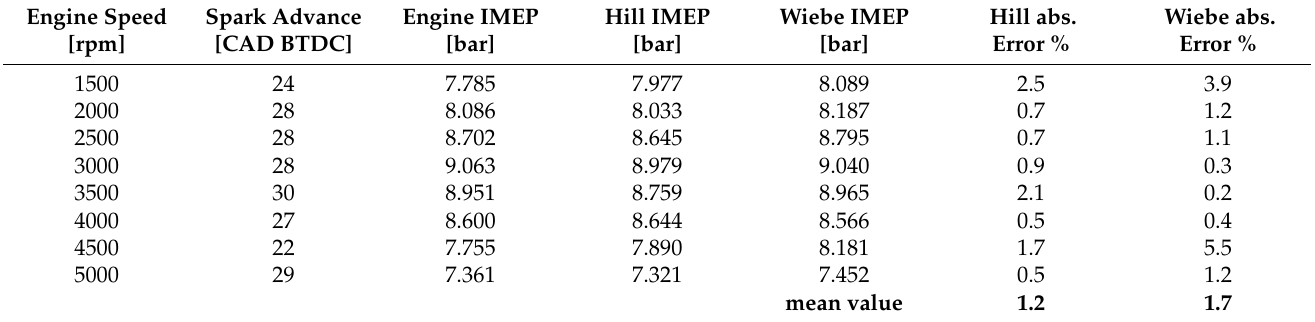
Table 8. Experimental and simulated IMEP with absolute prediction errors (60% NG; MAP = 1 bar).